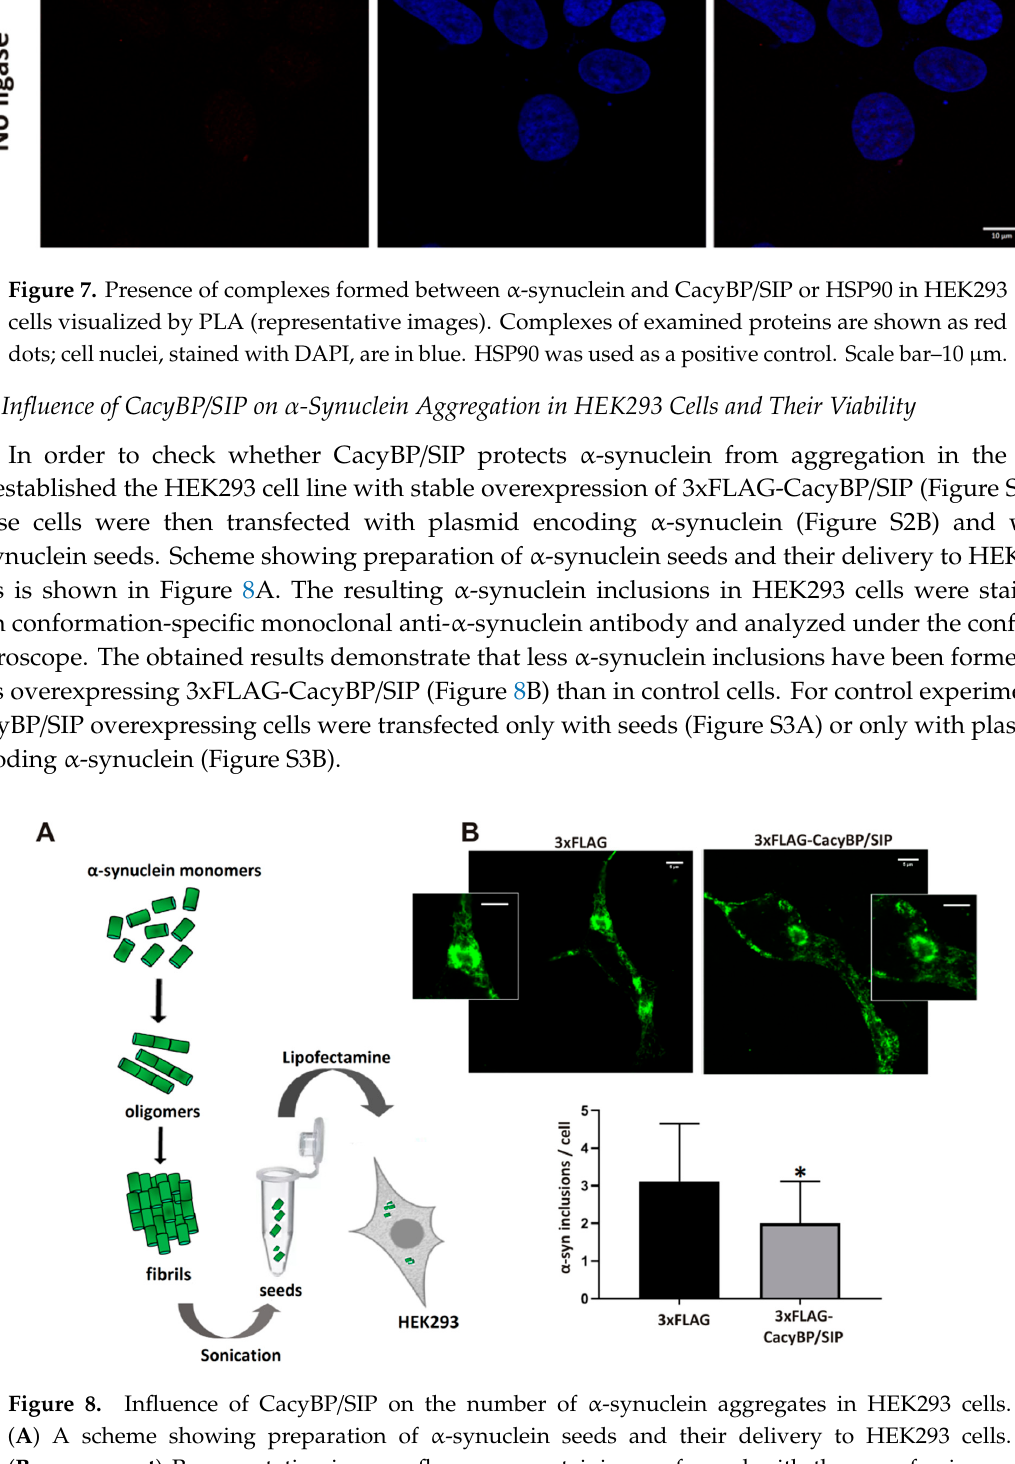
Figure 9. Viability of HEK293 cells overexpressing CacyBP/SIP after rotenone treatment. Cells treated with solvent (black bar), cells transfected with 3xFLAG (white bar) or with 3xFLAG-CacyBP/SIP (grey bar) treated with rotenone. Cell viability was quantified using an MTS